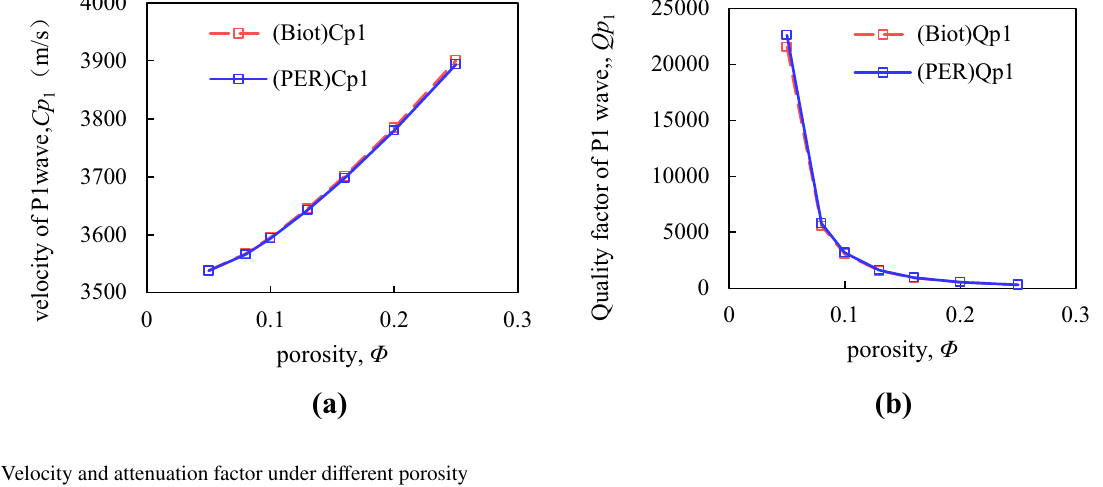
Fig. 4 Velocity and attenuation factor under different